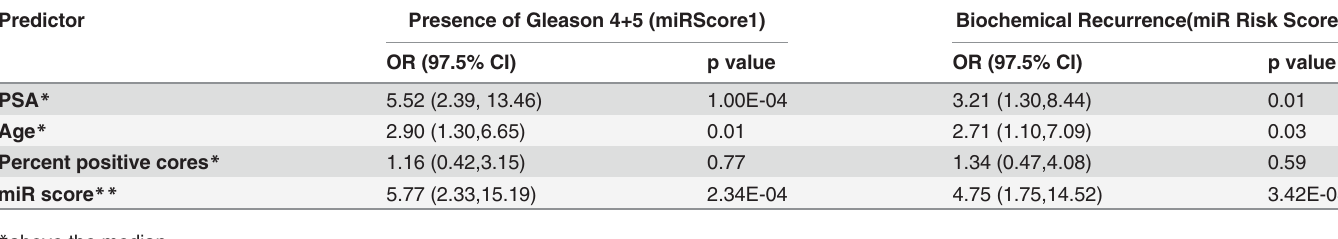
Table 3. Logistic regression analysis of pre-surgical predictors.